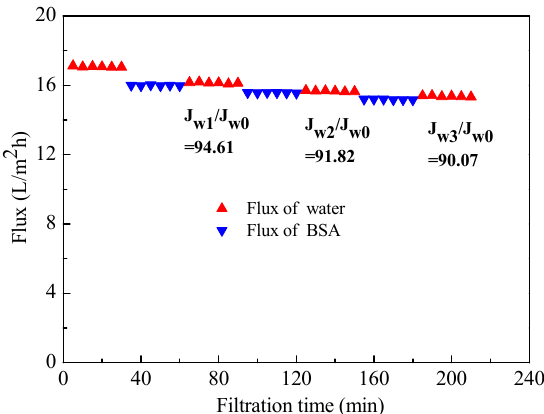
Figure 5. The alternating filtration flux between water and BSA solution of kaolin/CaAlg membrane.